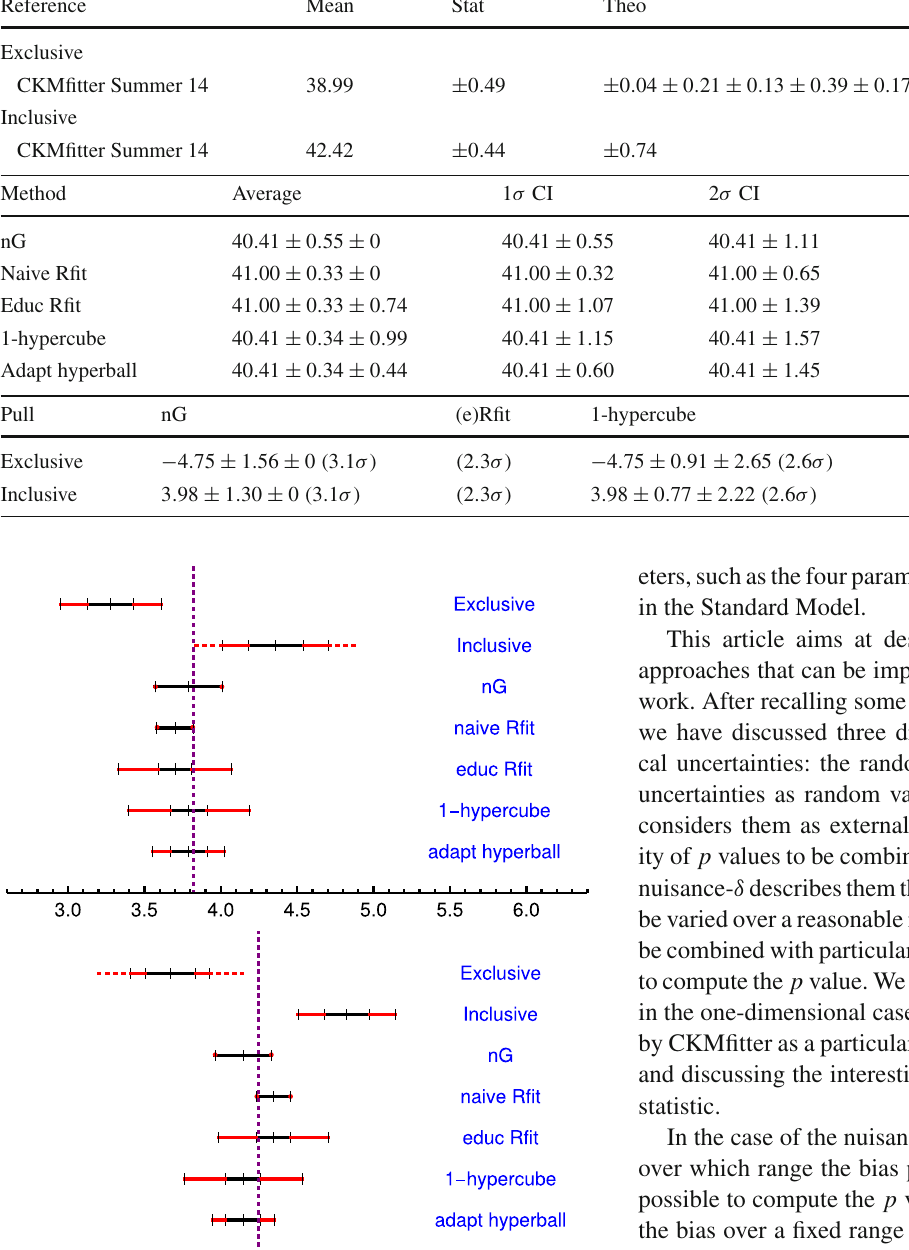
thesignificanceofthepull,whereasothermethodsyieldthepullparam- eter as well as the pull itself under the form p ± σ ± Δ (significance of the pull)